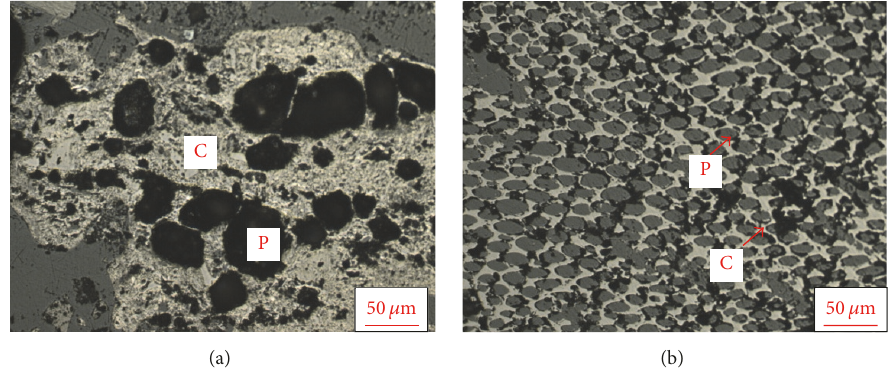
Figure 2: Microstructure of solid fuels: (a) coke breeze; (b) biochar; C: carbon; P: